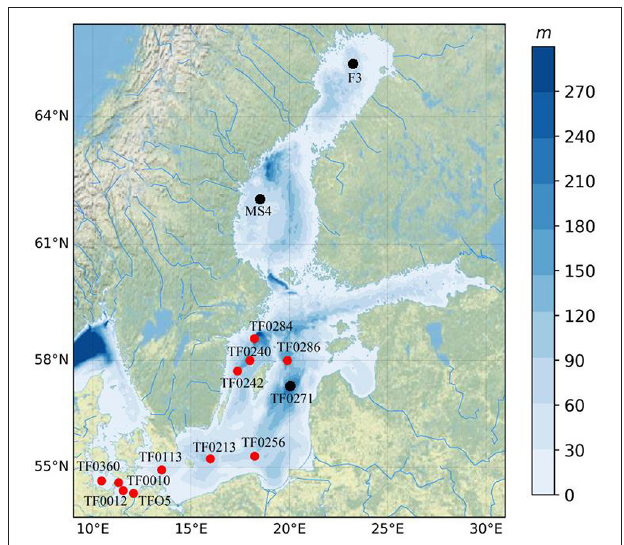
FIGURE 1 | Regional distribution of sampling stations for water and sediment in the Baltic Sea. (Red dot, both water, and sediment samples were sampled; black dot, only water samples were sampled. Sediment samples at stations TF0271, MS4, and F3 were not obtained due to bad weather conditions and resulting time